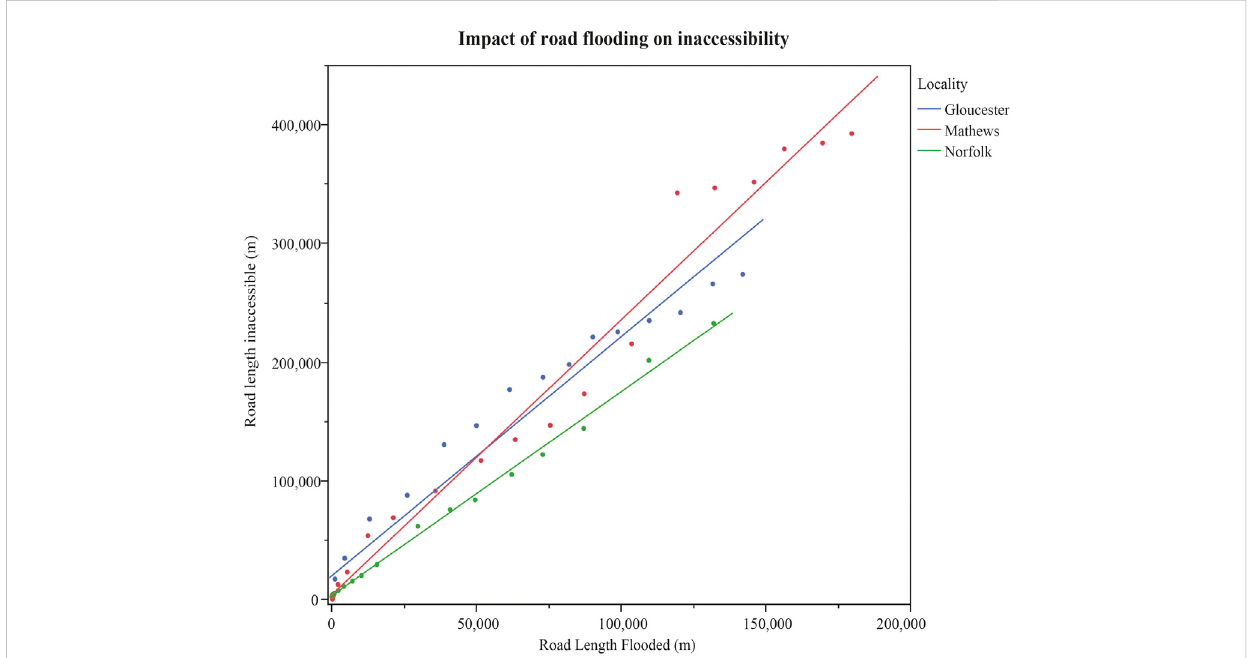
FIGURE 4 Comparison of road fl ooding length to the inaccessiblelength for fl ood elevations from 0.1 to 2.0 m NAVD88. Data for Gloucester is shown in blue, for Mathews isshowninred,and for Norfolk isshowningreen.The relationship for eachlocalityisshown separately. The slope oftheregressionline was 1.70, 2.08, and 2.36 for Norfolk, Gloucester, and Mathews, respectively. R 2 values for each locality: Gloucester = 0.96; Mathews = 0.98; Norfolk = 0.99.